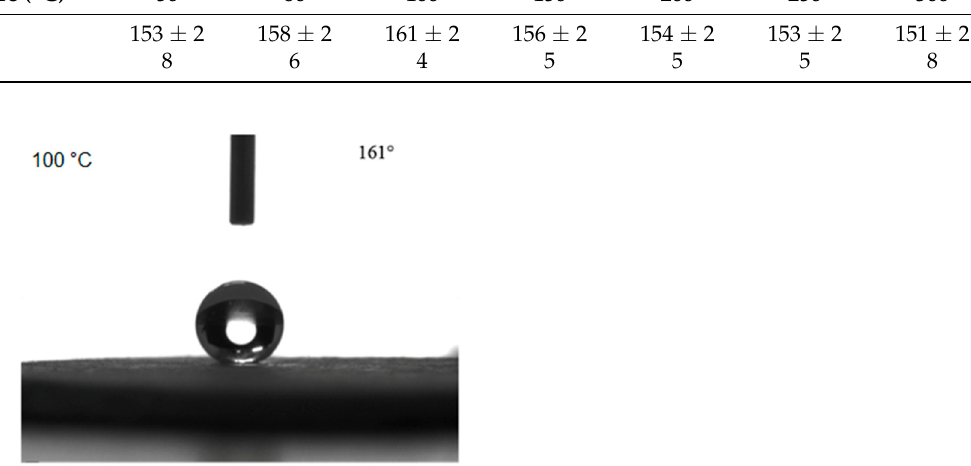
Table 1. Influence of heat treatment temperature on the contact angle and rolling angle of the superhydrophobic bulk sample. Heat Treatment Temperature ( ◦ C)